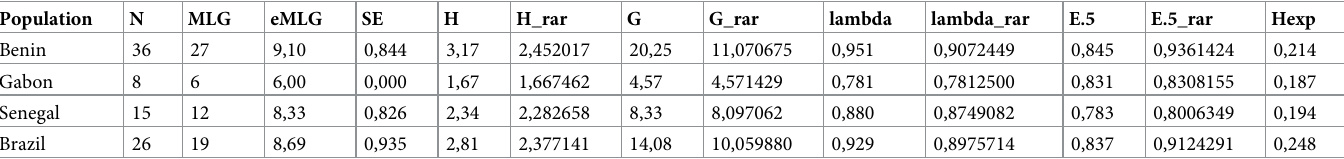
Table 1. Toxoplasma gondii genetic diversity and genotypic diversity.